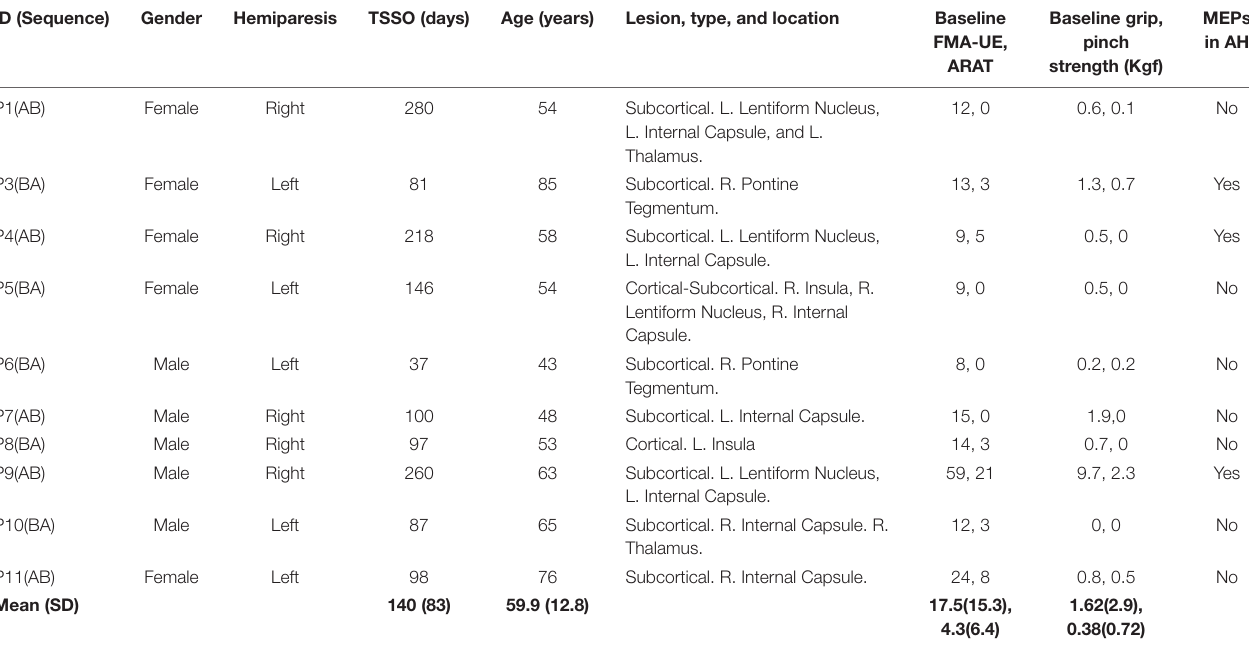
TABLE 1 | Demographic data of stroke patients included in the present study, including therapy sequence